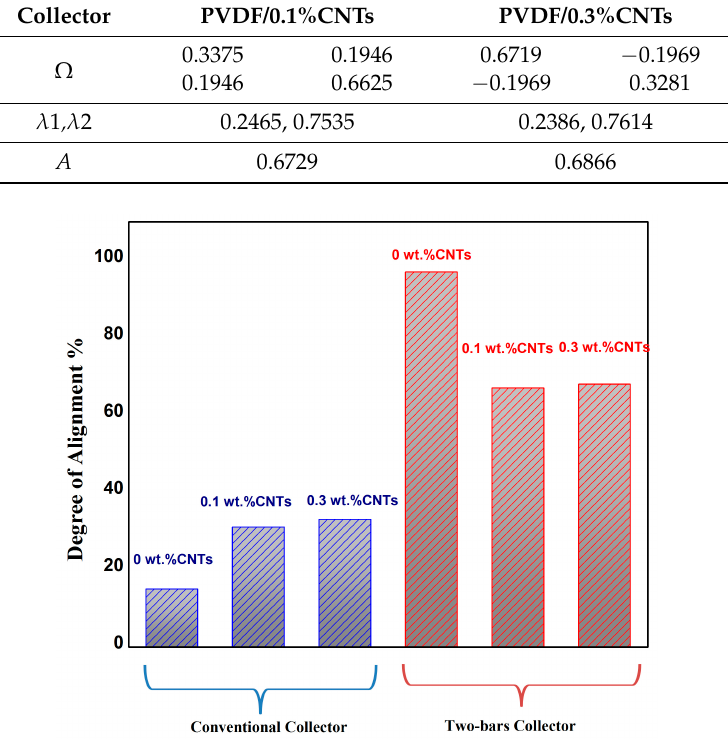
Table 3. Orientation matrices ( Ω ), Eigen values ( λ 1 , λ 2) and anisotropy index ( α ) for the 2 bars collector.